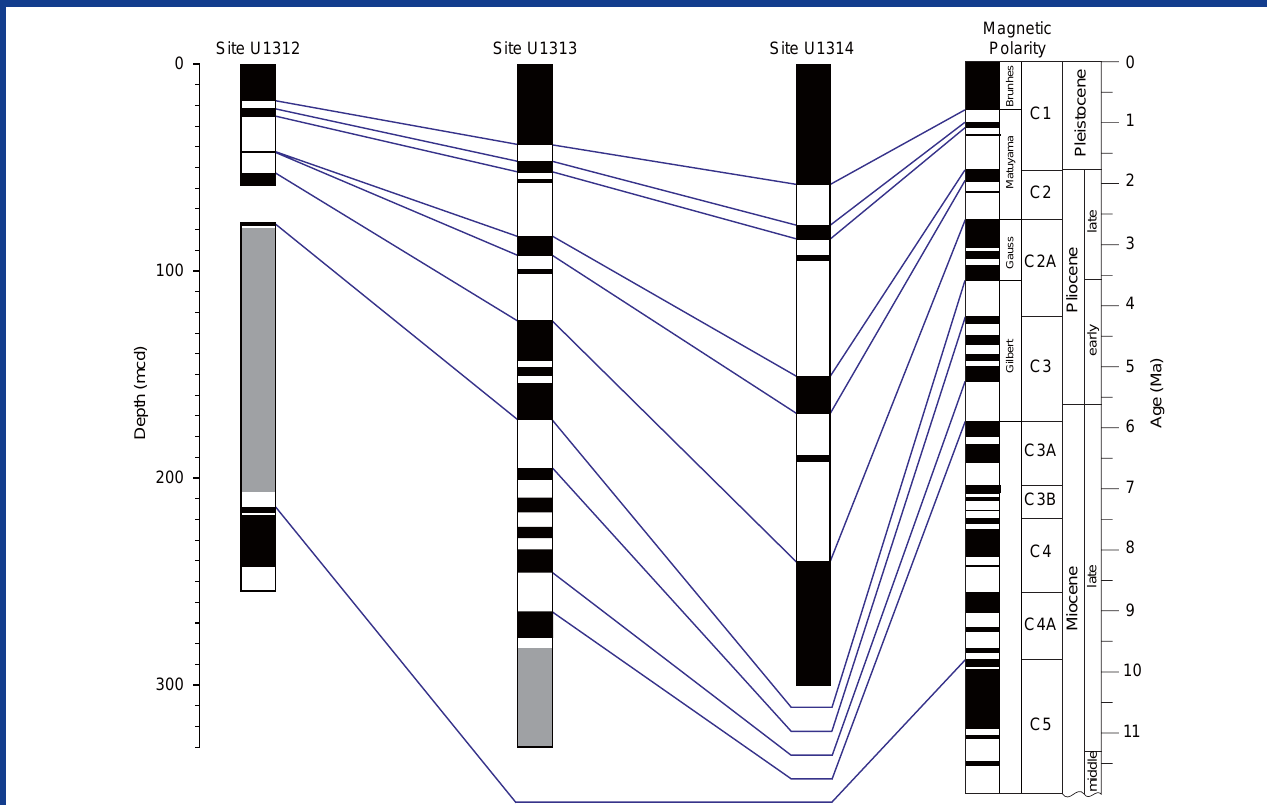
Figure 4. Expedition 306 schematic magnetostratigraphy. The paleomagnetic polarity interpretations (black = normal polarity, white = reversed polarity, gray = undetermined polarity) were obtained on the basis of shipboard inclination data acquired after 20 mT AF demagnetization. Continuous blue lines = principal magnetostratigraphic tie points used to establish the age models. Reference polarity timescale in right-side column from Cande and Kent (1992,